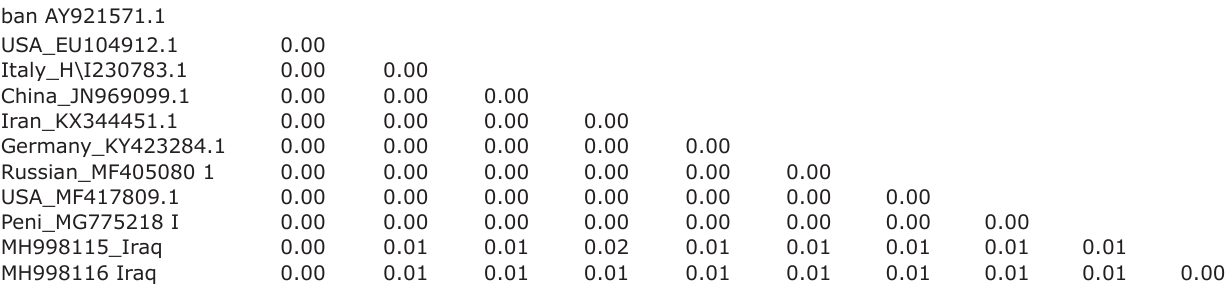
Table-1: Percentage of nucleotide divergence of 12 ILT isolates calculated by MEGA X program software. ban